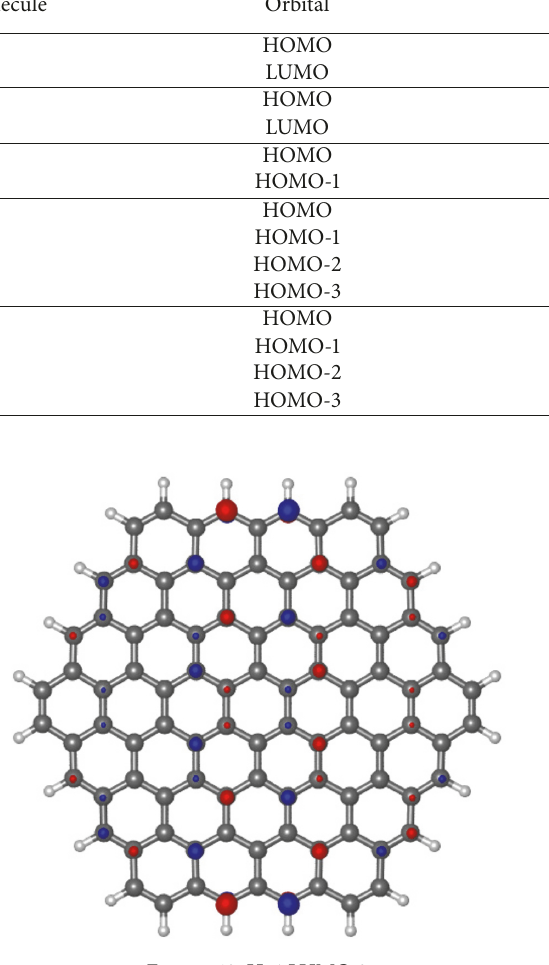
Figure 12: H 4 LUMO 2.